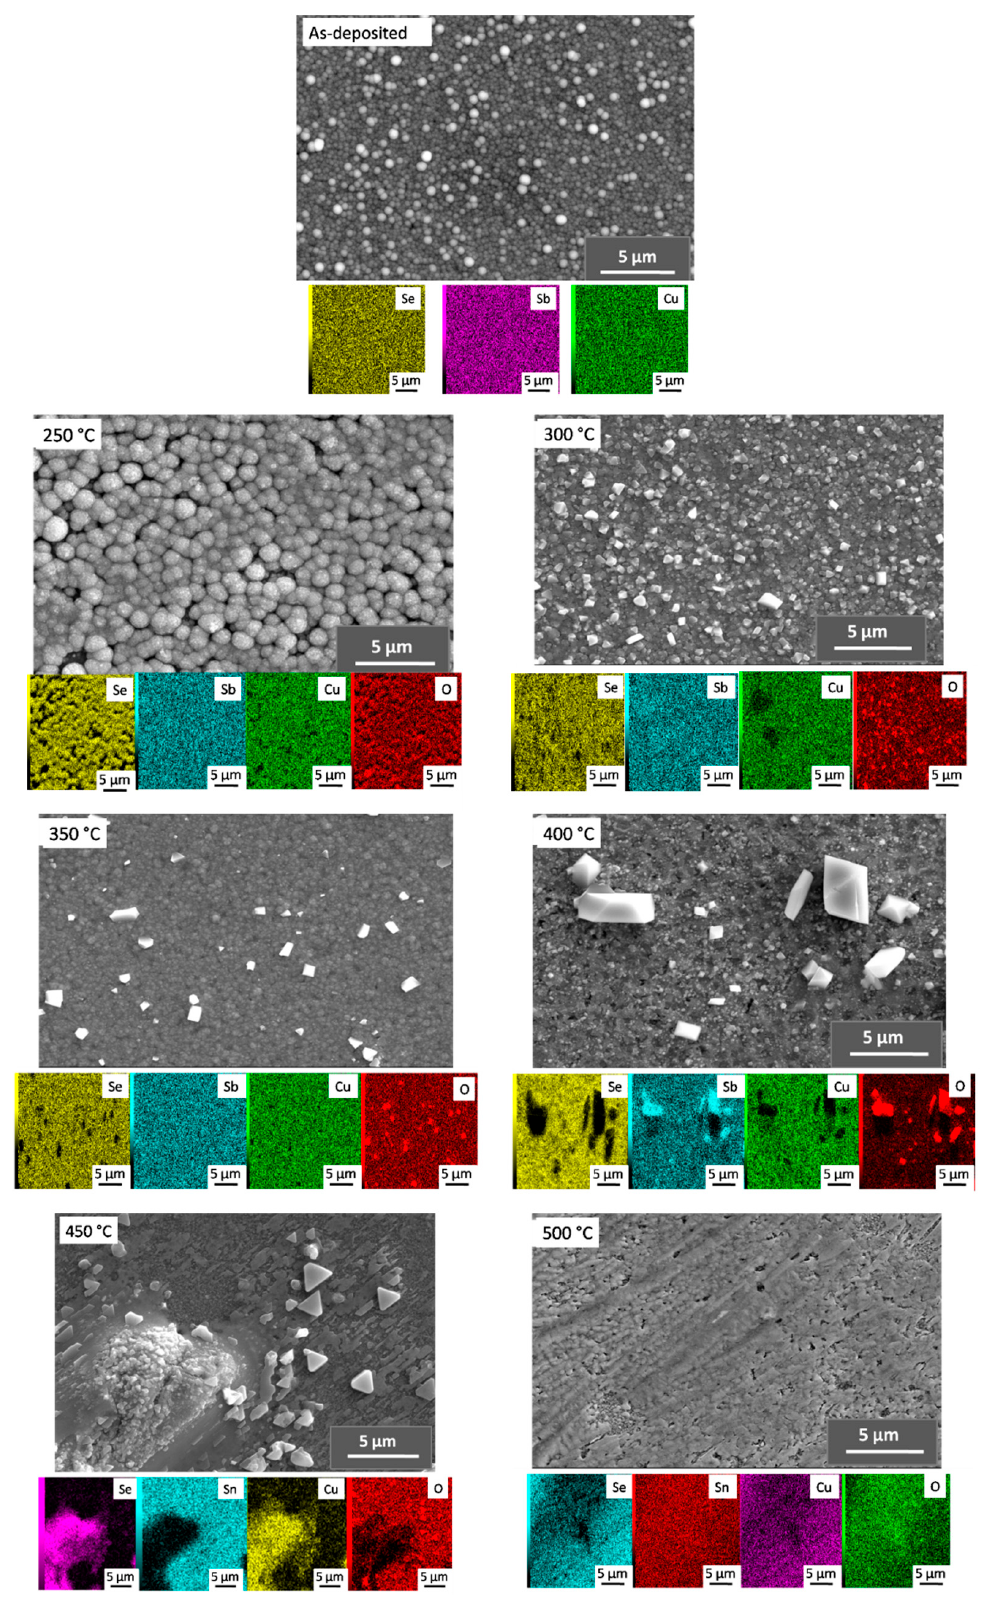
Figure 3. SEM/EDS-mapping of CuSbSe 2 thin films, electrodeposited at − 0.4 V/SCE during 30 min: as-deposited and annealed respectively at 250, 300, 350, 400, 450 and 500 °C under N 2 for 10 min.